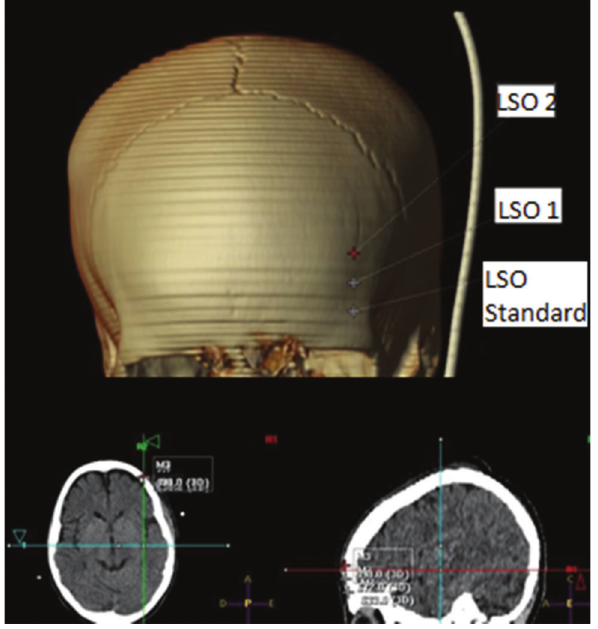
Figure 2 - Example of the sites for the standard LSO, LSO 1 and LSO 2 points.